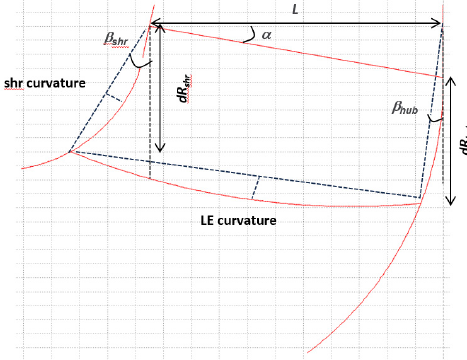
Figure 2. Meridional geometry parametrization.